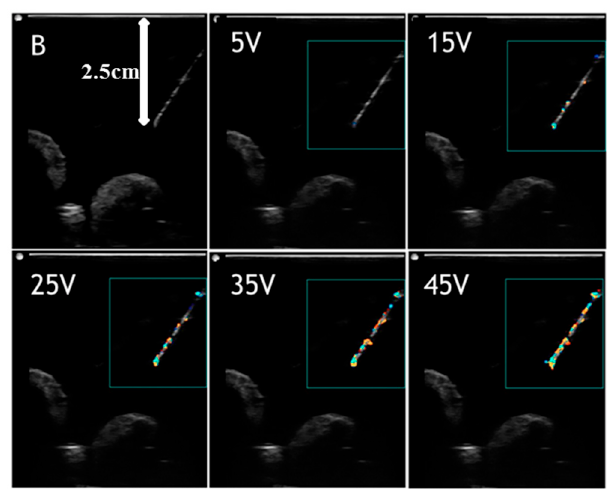
Figure 4. Visualized vibrating needle in gelatin phantom at an angle of 60° and a depth of 2.5 cm with voltages (5, 15, 25, 35, 45 V).